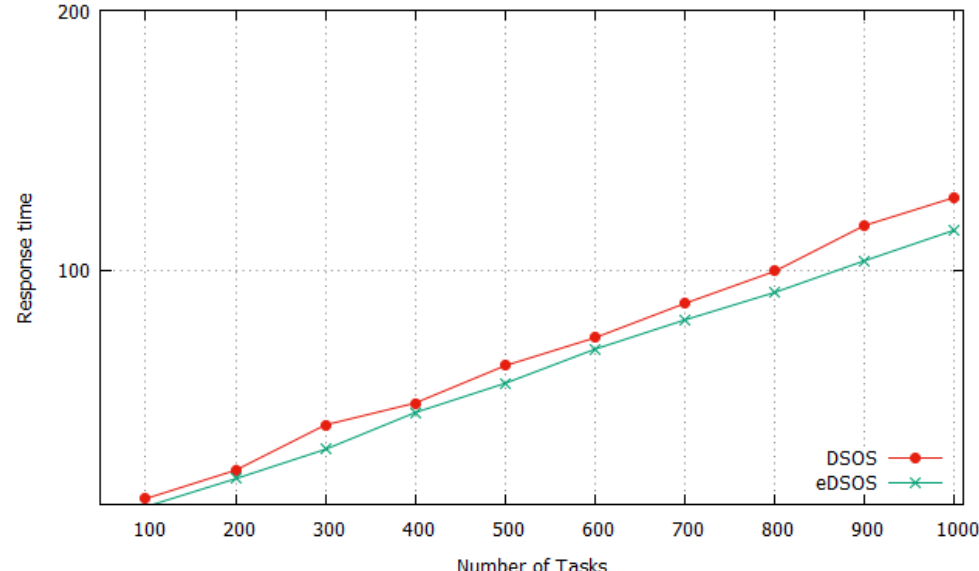
Figure 10. Response time for the dataset with the uniform distribution.